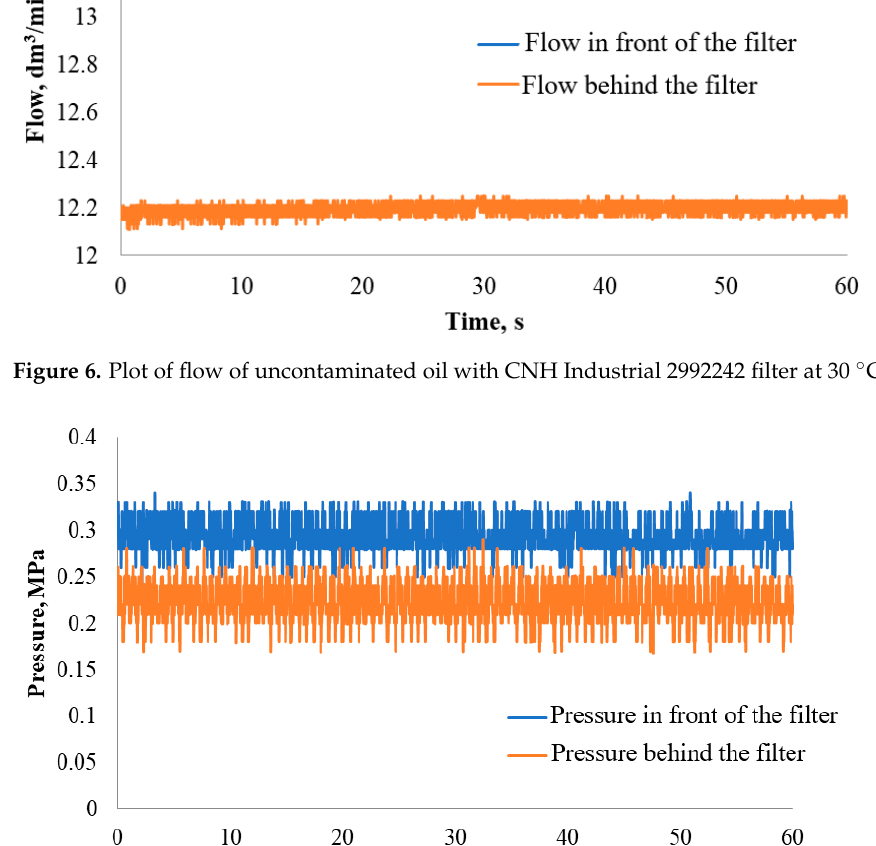
Figure 7. Plot of pressure of contaminated oil with MANN W950/26 filter at 30 °C. Figure 8. Plot of flow of contaminated oil with MANN W950/26 filter at 30 °C. Figure 8. Plot of flow of contaminated oil with MANN W950/26 filter at 30 °C.